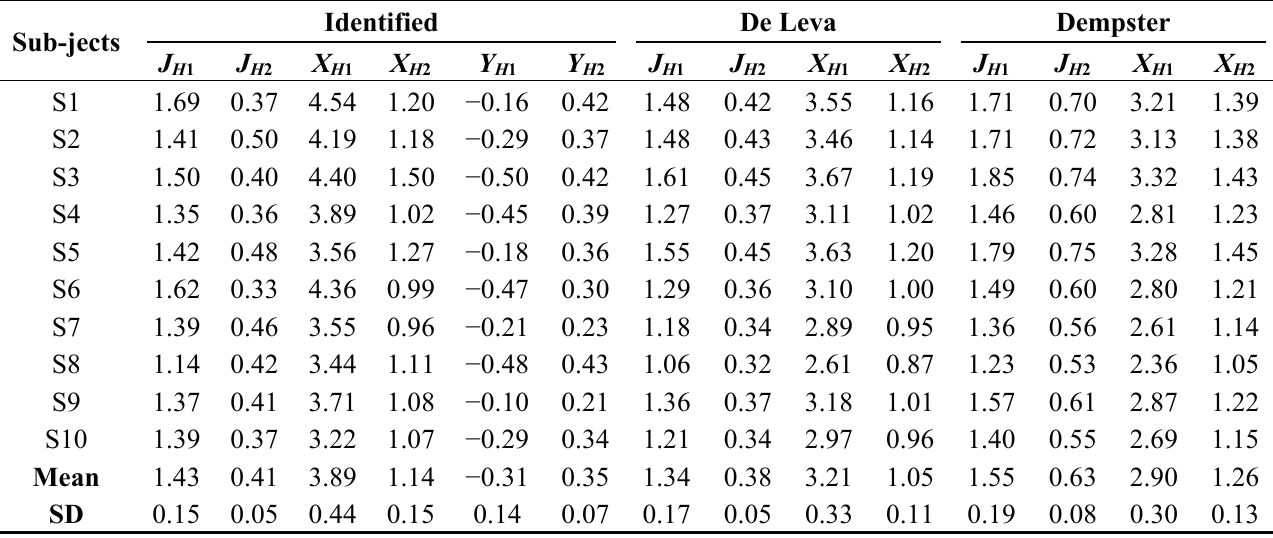
Table 4. Parameter identification results for the human body ( J (kg·m 2 ), X (kg·m), Y (kg·m)).